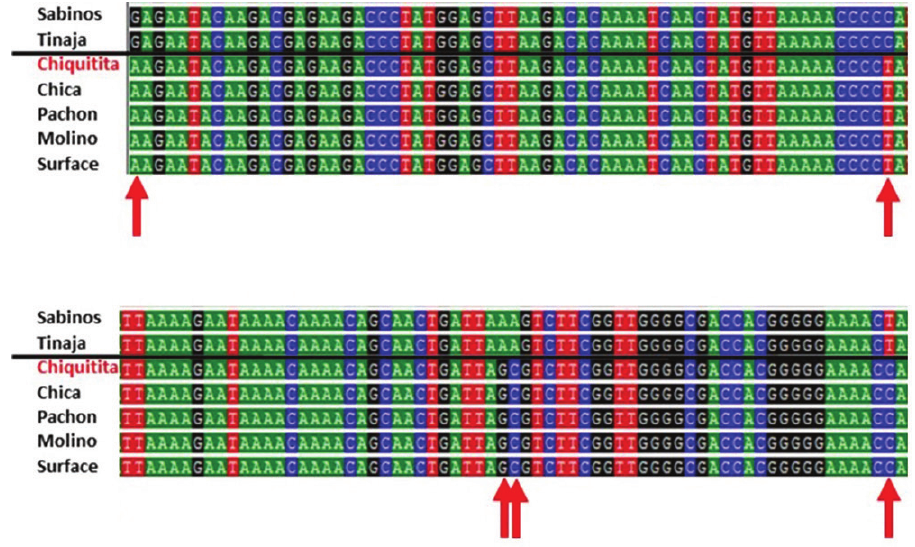
Figure 6. Fragment of the mitochondrial 16S rRNA. Individuals from Chiquitita Cave have identical sequence to members of the “ A ” lineage (Chica cave, Pachón cave, Molino cave and Rio Comandante surface river). Members of the “ B ” lineage (Sabinos cave and Tinaja cave) have 5-6 bp disagreements in this fragment, indicated by red